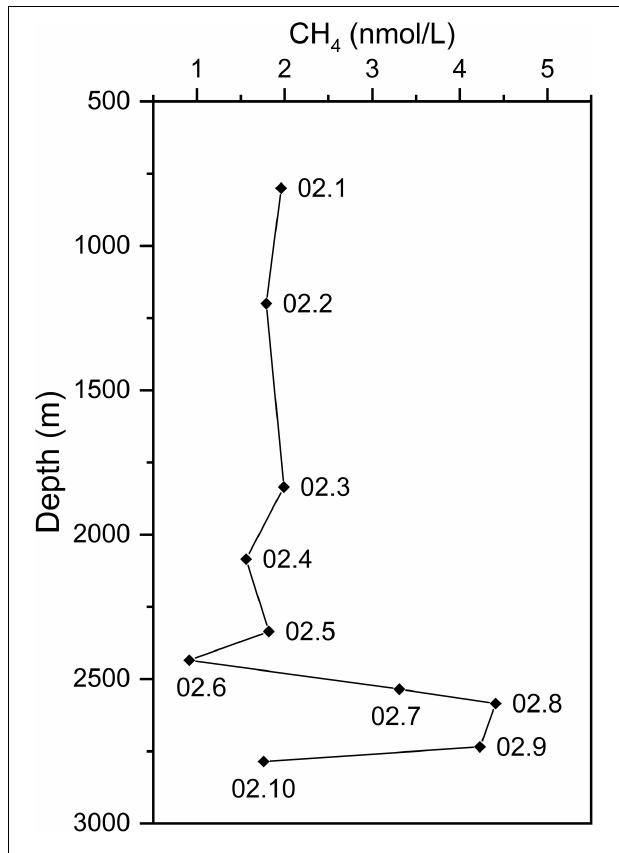
FIGURE 2 | The profile of methane concentrations along the CTD02 water column above the Longqi vent field. Based on the anomalies of methane concentration, three samples, CTD02.7, 02.8, and 02.9, were identified as the non-buoyant plume